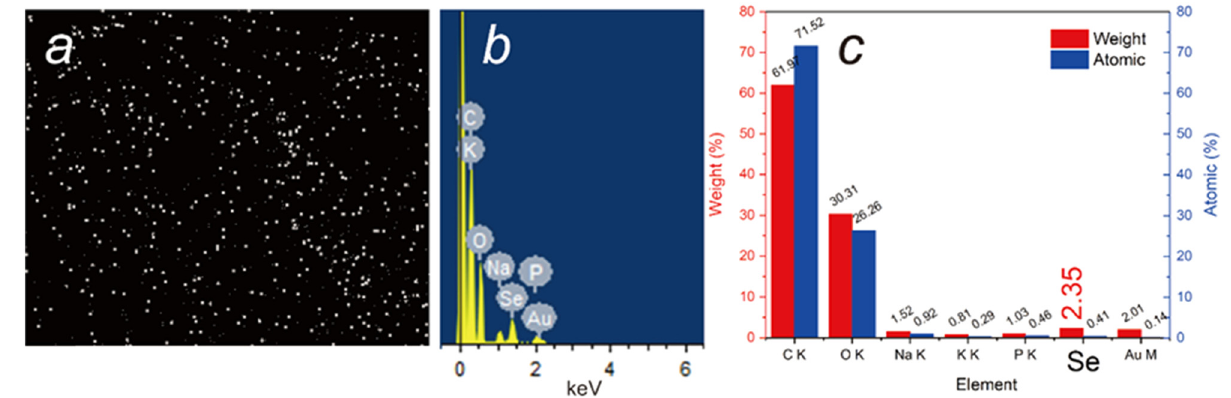
Figure 4: EDS spectrum of synthesized sample and results of its elemental analysis: ( a ) distribution spectrum of selenium in the sample, ( b ) energy spectra of each element contained in the sample and ( c ) content of each element in the sample.